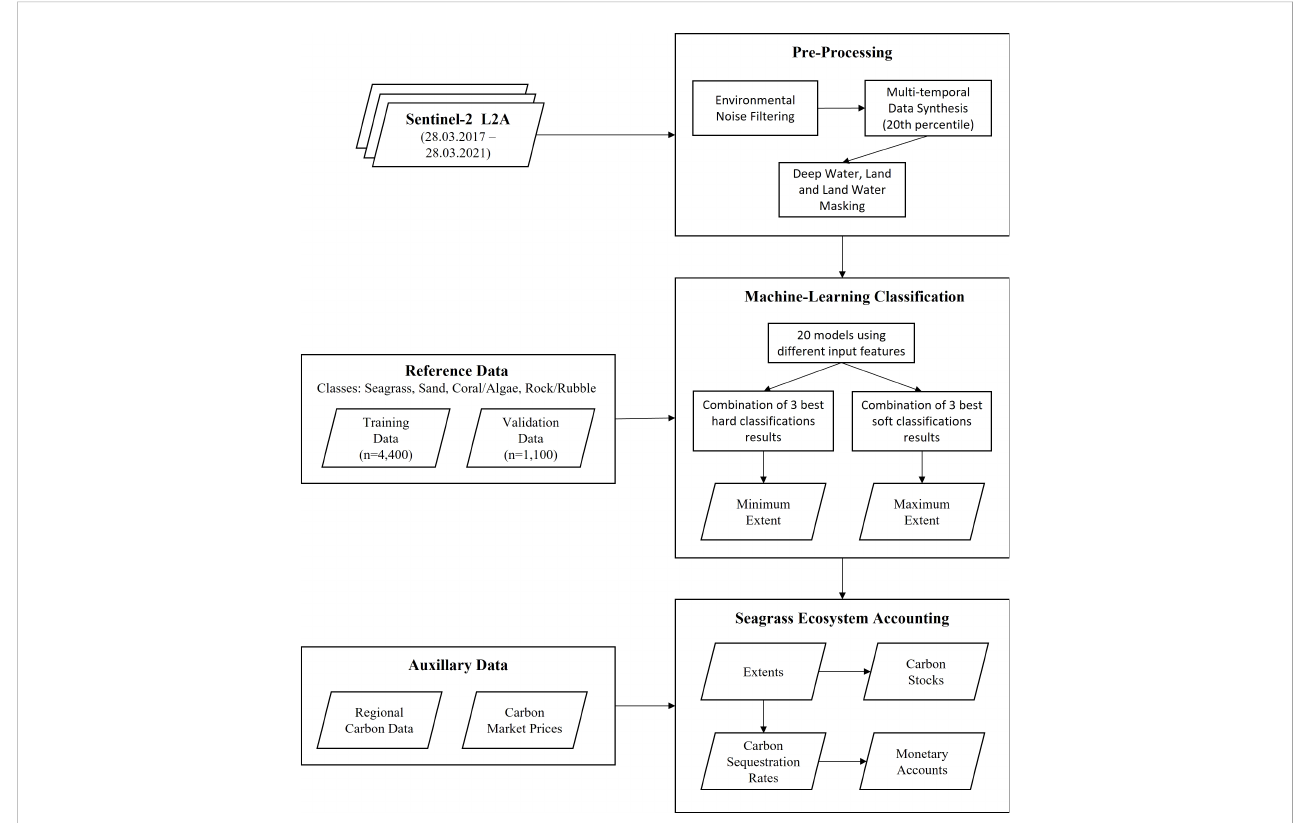
FIGURE 1 Schematic work fl ow of the cloud-native Earth Observation seagrass ecosystem accounting